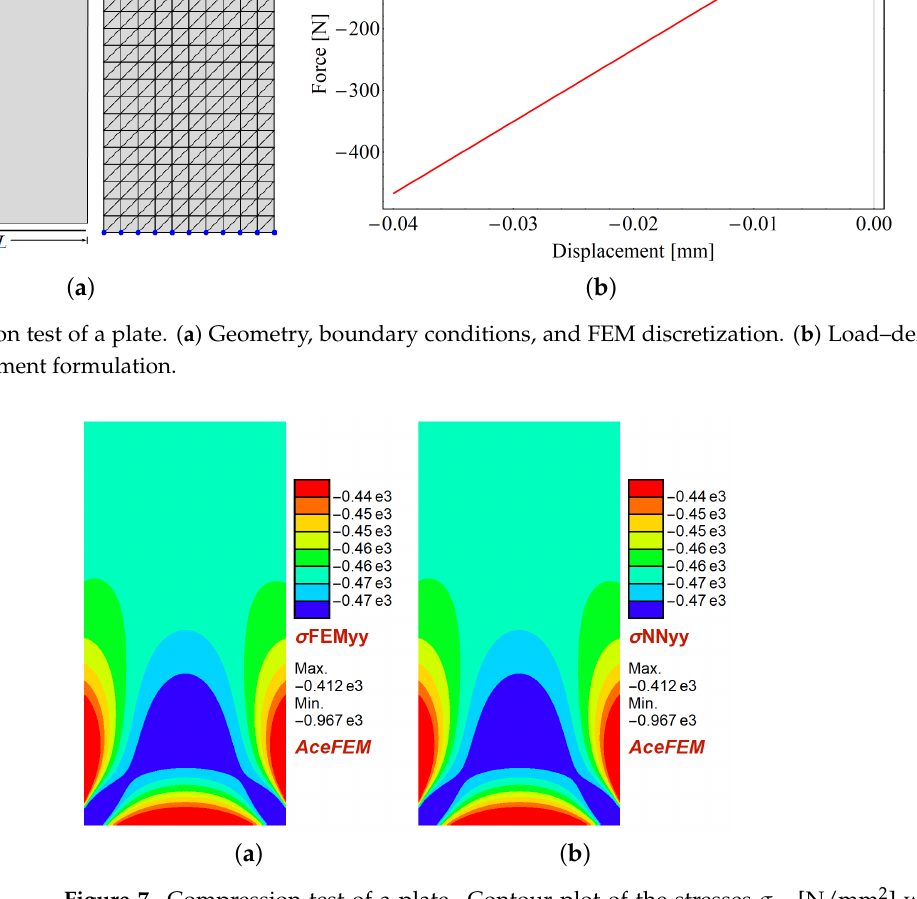
Figure 7. Compression test of a plate. Contour plot of the stresses σ yy [N/mm 2 ] with ( a ) finite element method, and ( b ) neural network formulation.